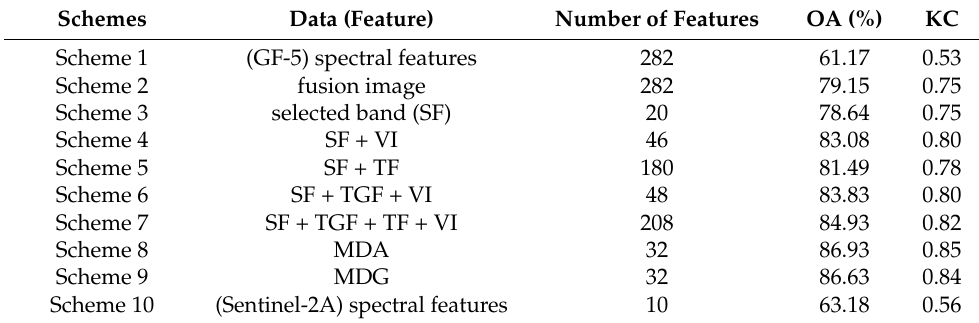
Table 5. Classification results of different schemes.